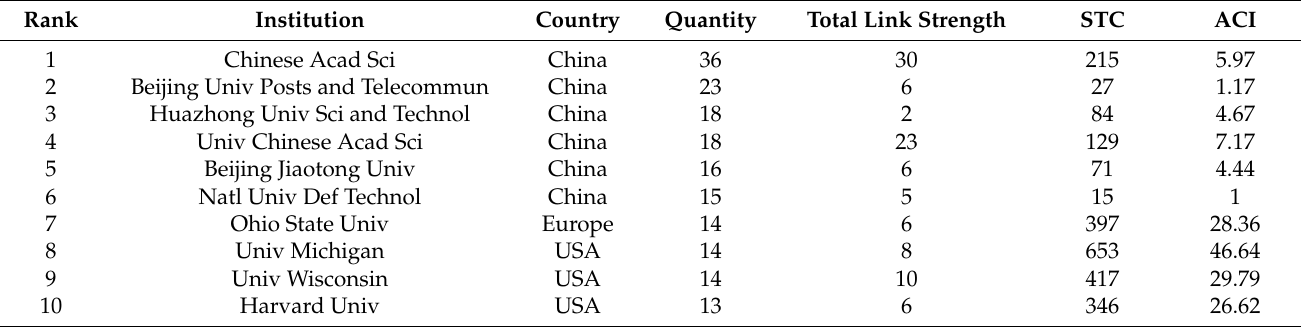
Table 4. The top 10 institutions in NPO studies,